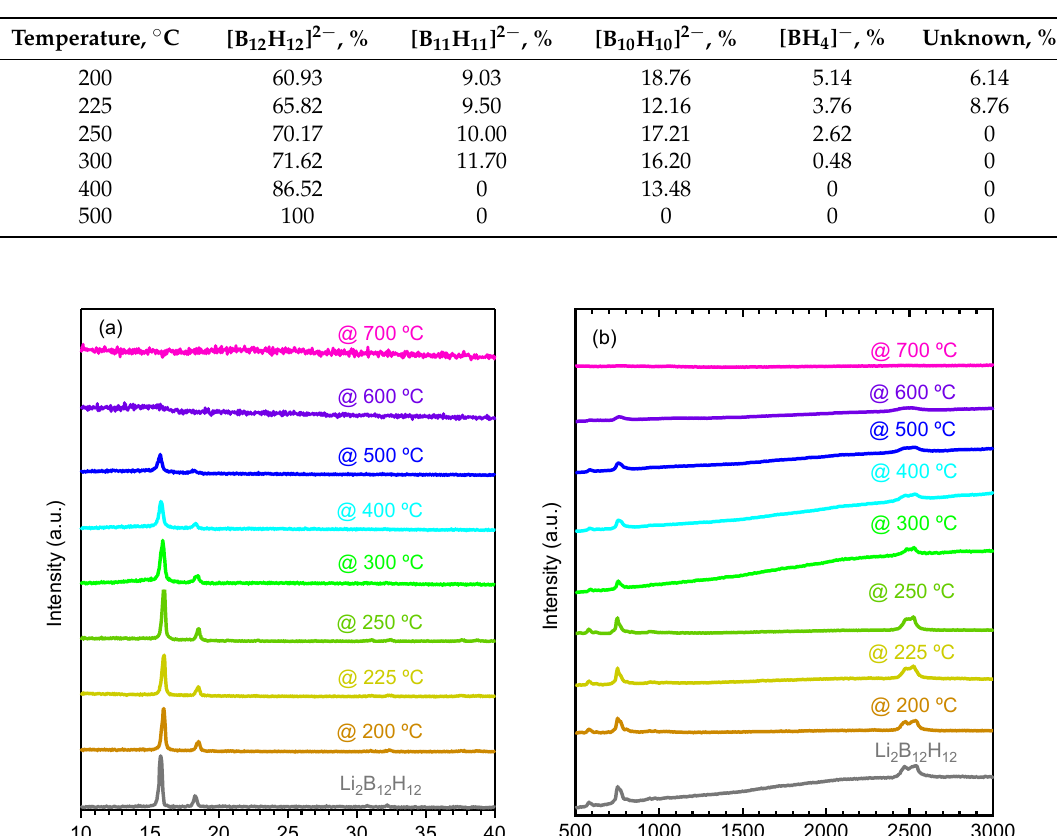
Figure 3. Ex-situ 11 B and 1 H NMR spectra of anhydrous Li 2 B 12 H 12 and heated up to respective temperatures: ( a ) solid-state 11 B MAS NMR spectra, ( b ) solution-state 11 B NMR spectra measured in DMSO-d 6 and ( c ) solid-state 1 H MAS NMR spectra. Resonance assignments of 11 B spectra: − 15.6 ppm [B 12 H 12 ] 2 − , − 35.6 ppm [BH 4 ] − , − 0.9 & − 28.8 ppm [B 10 H 10 ] 2 − , − 16.8 ppm [B 11 H 11 ] 2 − , − 20.3 ( − 20.8) ppm [B 9 H 9 ] 2 − [30]. Resonance assignments of 1 H spectra: 1.2 ppm [B 12 H 12 ] 2 − [10,16]. The thermal decomposition pathway of anhydrous Li 2 B 12 H 12 up to 700 °C is, therefore, summarized based on the abovementioned experimental results: Step 1: Li 2 B 12 H 12 → Li 2 B 12 H 12 − x + x /2H 2